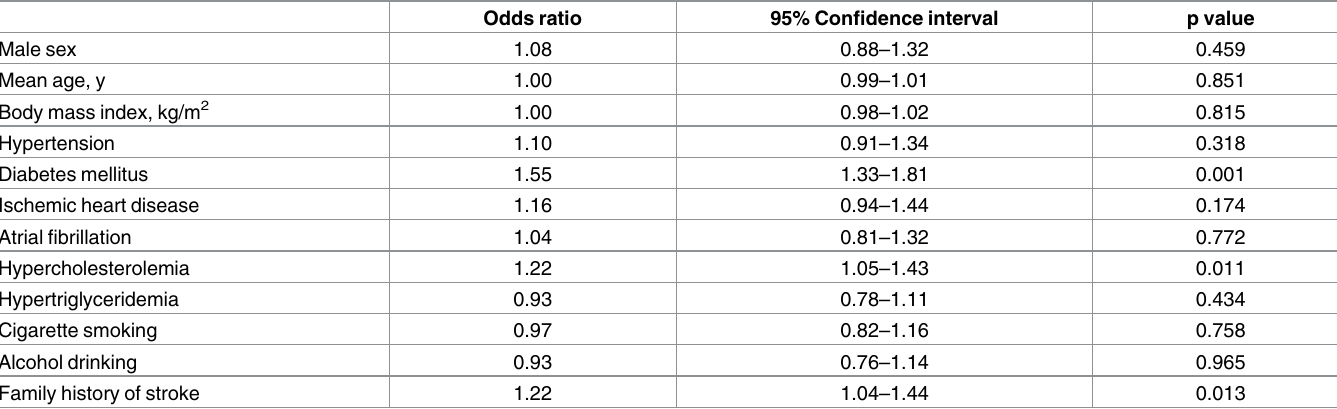
Table 2. Multivariate analysis of factors related to MCA stenosis.